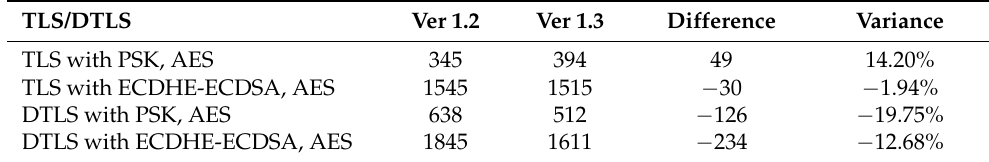
Table 4. Comparing TLS/DTLS network traffic overhead.